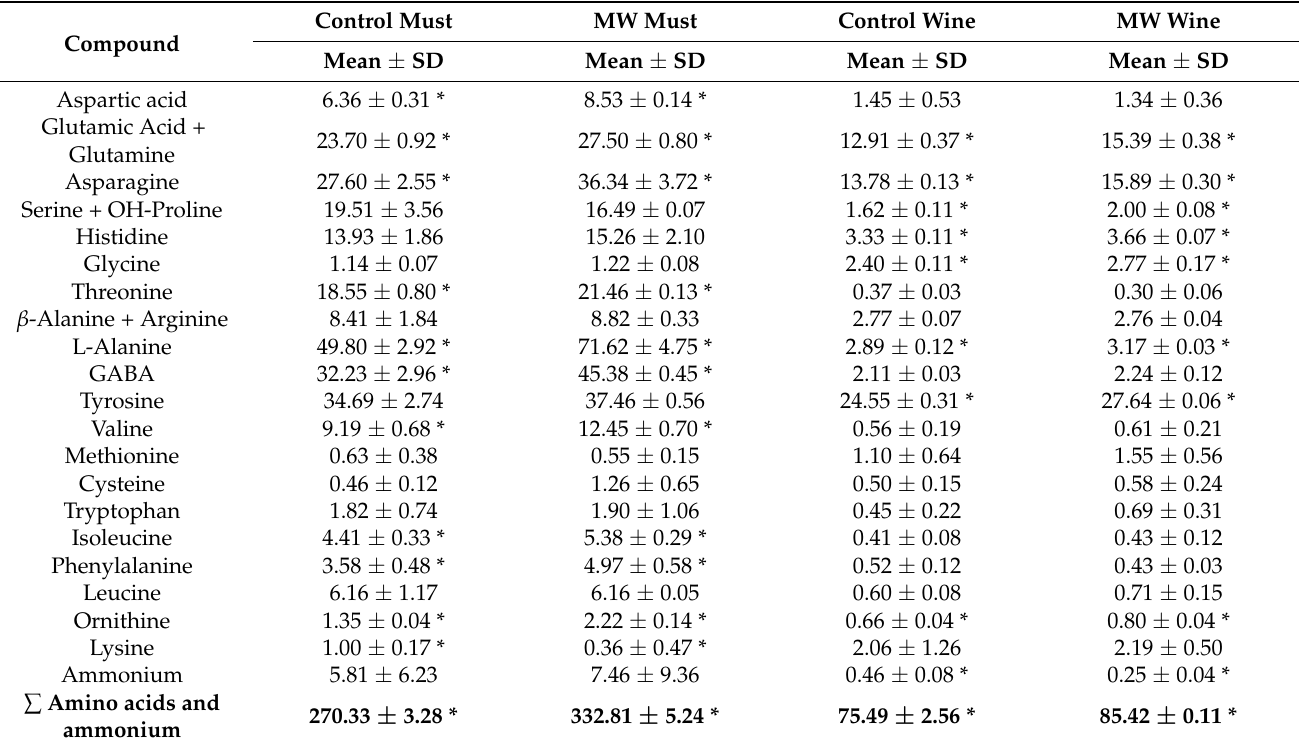
Table 3. Amino acid composition and ammonium content (mg/L) of musts and wines (control samples and samples from microwave